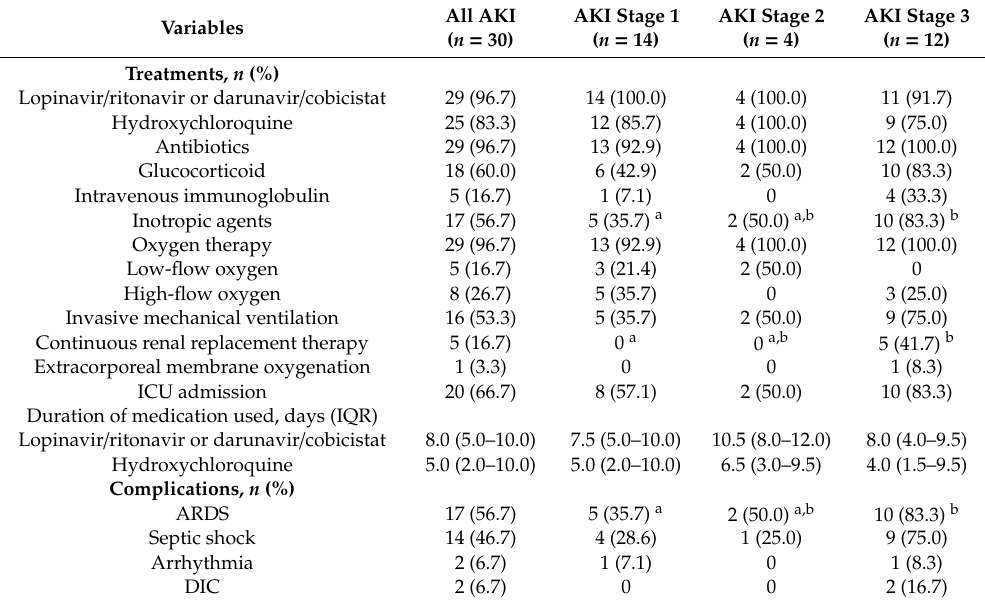
Table 3. Treatment and complications in AKI patients.